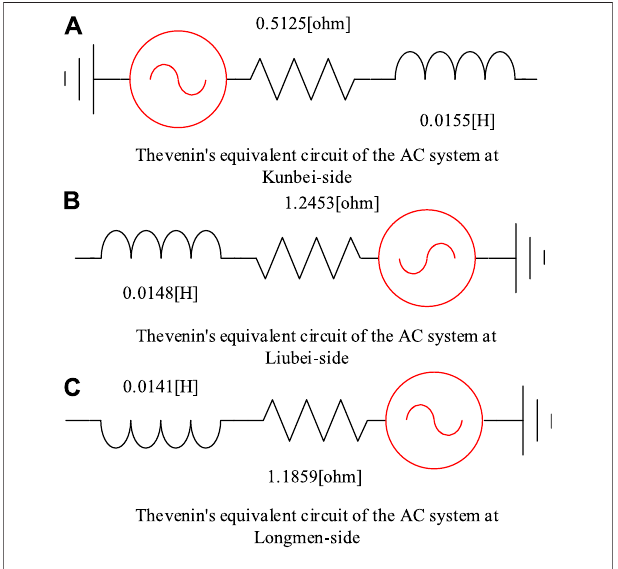
FIGURE 1 | Thevenin ’ s equivalent circuit of the AC system.